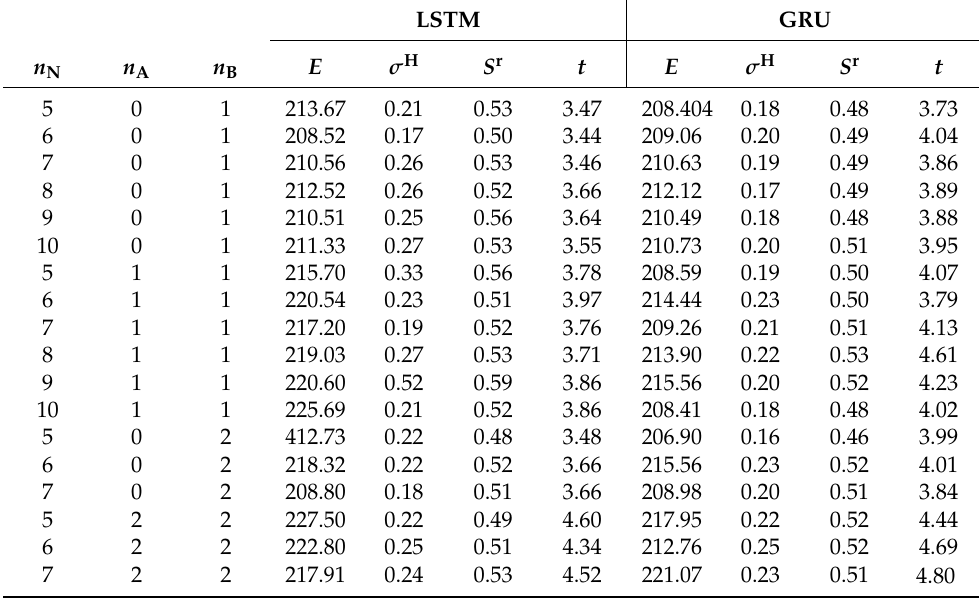
Table 6. The neutralisation reactor: quality indexes and average time of calculation